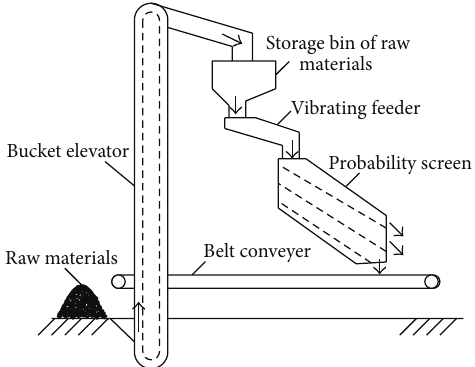
Figure 1: Schematic diagram of the vibration sieving test bench.